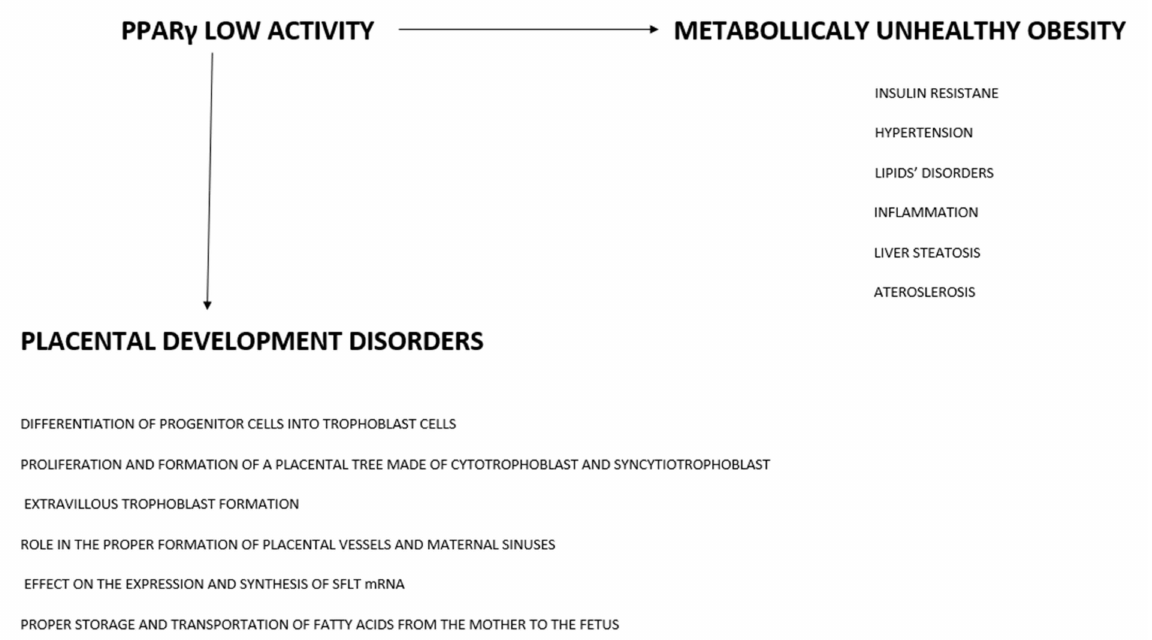
Figure 2. Diagram showing PPAR γ —a factor linking metabolically unhealthy obesity with placental